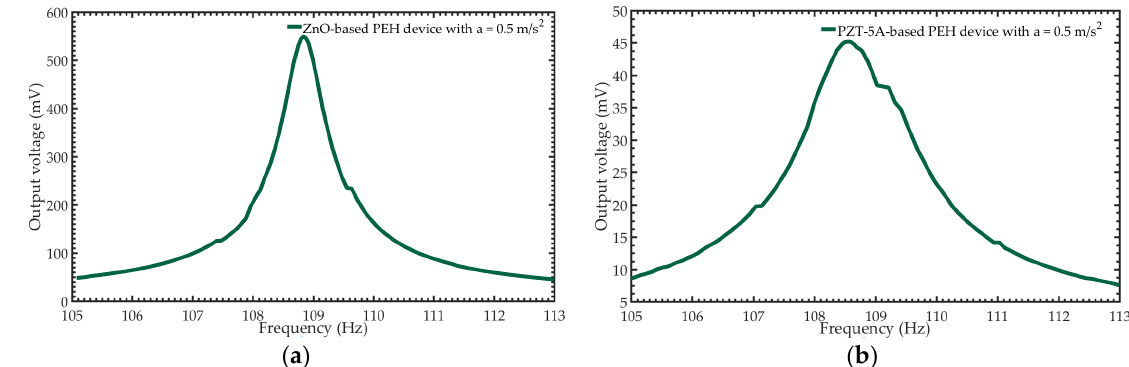
Figure 8. Generated voltages as function of the frequency of the PEH devices with ZnO ( a ) and PZT-5A ( b ) layers.